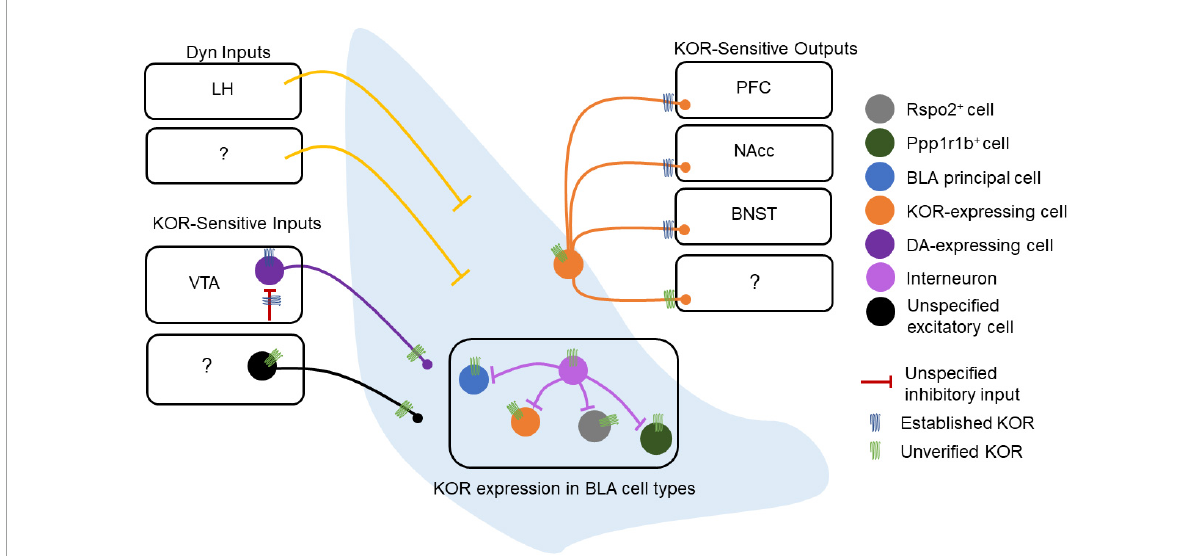
FIGURE2 Dynorphin/kappa opioid receptor expression in basolateral amygdala (BLA) circuitry. Schematic of the experimentally-established components of the BLA Dyn/KOR system [e.g., verified kappa opioid receptors (KORs)] as well as some outstanding questions (e.g., unverified KORs). The lateral hypothalamus (LH) is the only structure currently reported to send Dyn inputs to the BLA, while other potential sources of Dyn to the BLA remain to be discovered. Other inputs to the BLA are regulated by the Dyn/KOR system as well. The VTA expresses KORs at DAergic cell bodies, and these same cell bodies are regulated by an inhibitory input that expresses KOR presynaptically, suggesting that the Dyn/KOR system may modulate the release of other neuromodulators such as DA into the BLA. These VTA inputs, as well as other potential inputs to the BLA, may also express KORs presynaptically. The BLA does not contain Dyn neurons, and the cell type-specific expression of KOR in BLA neurons is also poorly understood. Similarly, whether local BLA interneurons express KOR, and, if so, whether KOR + and KOR − interneurons differentially regulate different populations of BLA neurons is unknown. KOR + BLA principal neurons target the PFC, NAcc, and BNST, other projection targets of KOR-expressing neurons remain to be discovered. Likewise, whether KOR is present at somatodendritic compartments or regulates local collaterals within the BLA is not